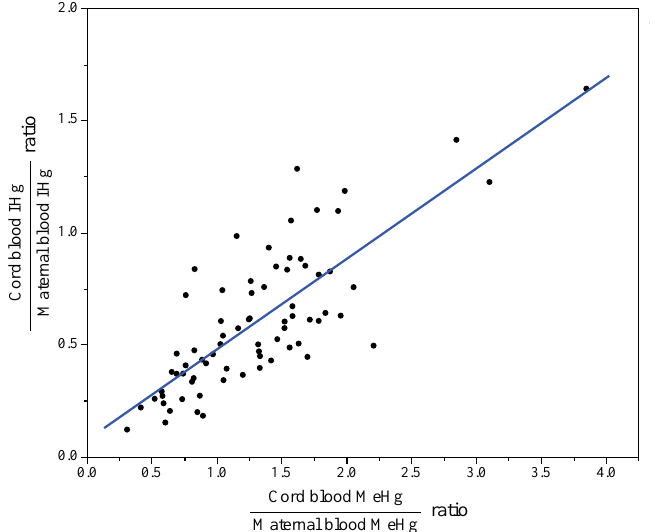
Figure 4. Relationships between cord blood:maternal blood ratios of inorganic mercury (IHg) and methylmercury (MeHg). Y = 0.07 + 0.40 × ( p < 0.001).